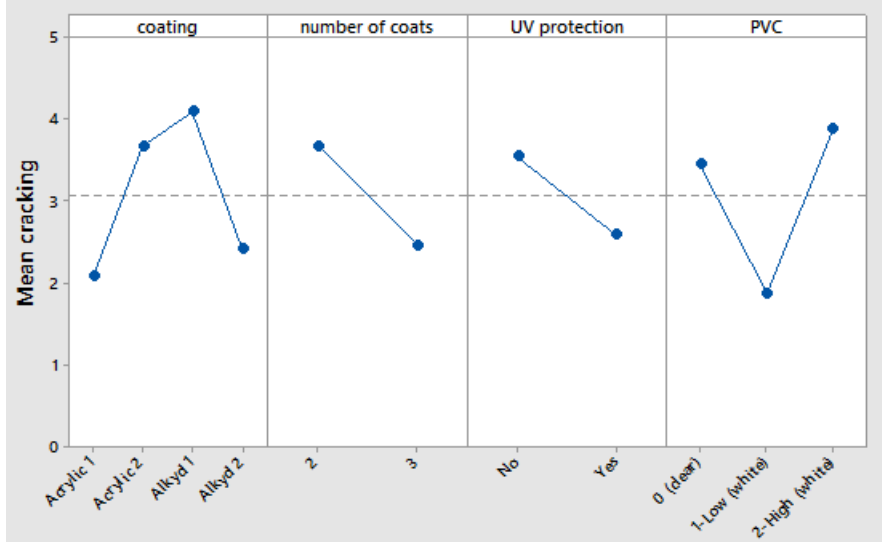
Figure 7. Main effects plot for the mean cracking.